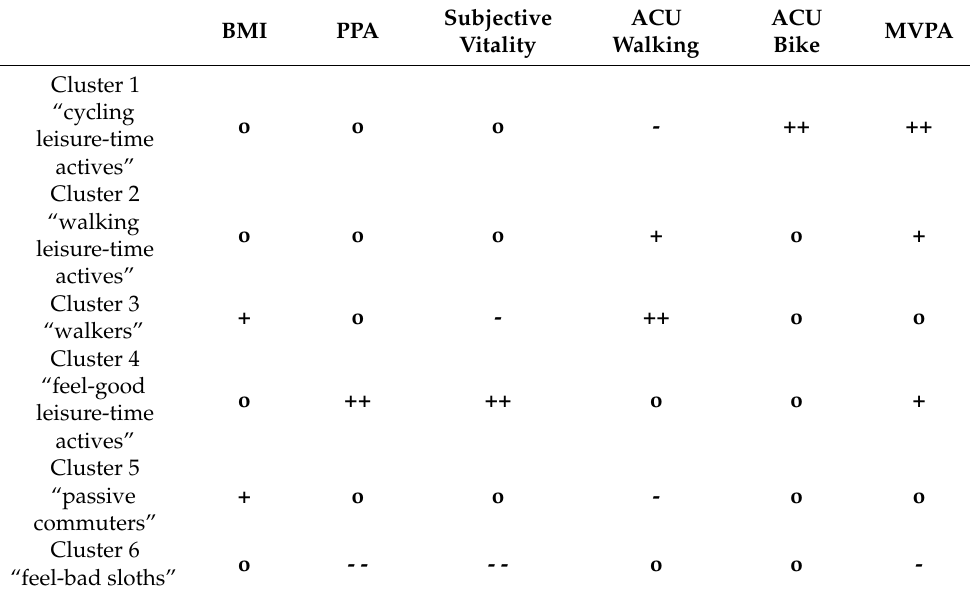
Table 5. Male clusters’ mean values in the input variables according to